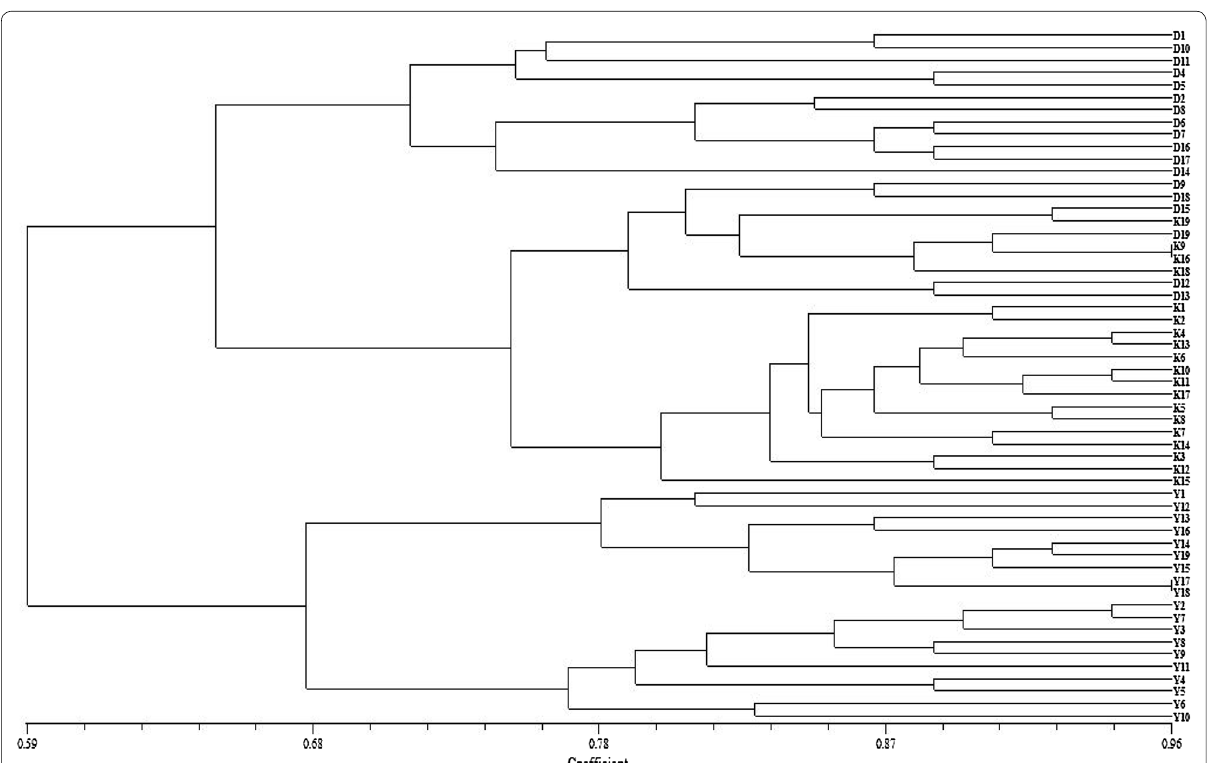
Fig. 9 Dendrogram of all samples generated by unweighted pair group method with arithmetic averages (UPGMA) cluster analysis of genetic similarity values determined using Inter‑Simple Sequence Repeats (ISSR). K1–K19, Kufranjah valley (northern population); D1–D18, Dead Sea region (northern population); Y1–Y19, Wadi al Yutm (southern